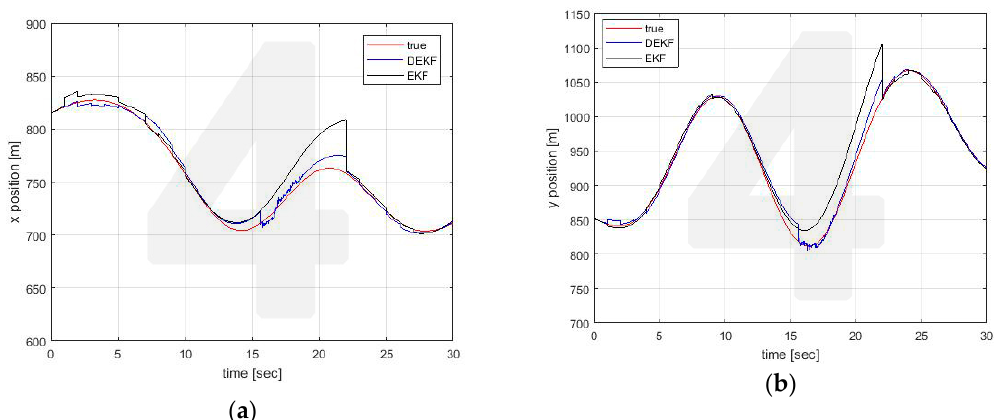
Figure 7. Position estimation performed by Vehicle 1 on Vehicle 4 position ( a ) x axis ( b ) y axis.